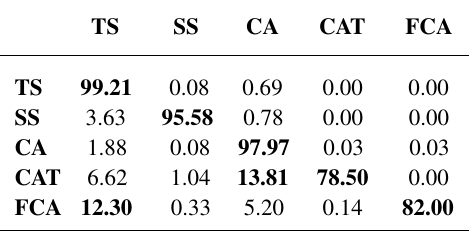
Table 13. Confusion matrix December 2018